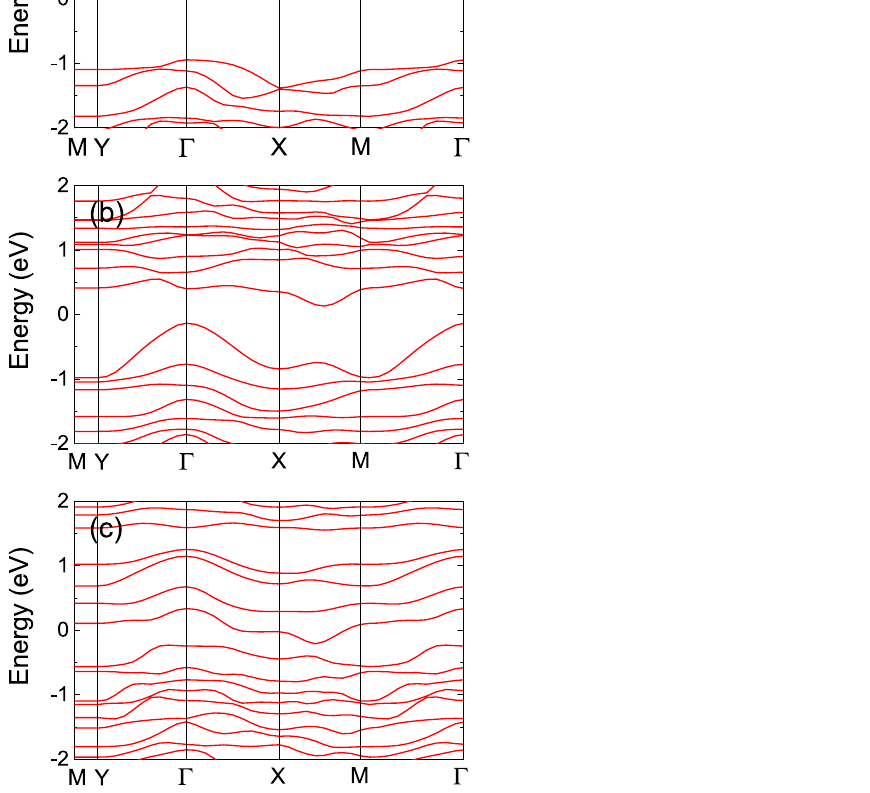
Figure 4. Calculated electronic band structures of ReSe 2 with ( a ) R = 1:2, ( b ) R = 1:1.75, and ( c ) R = 1:2.667.